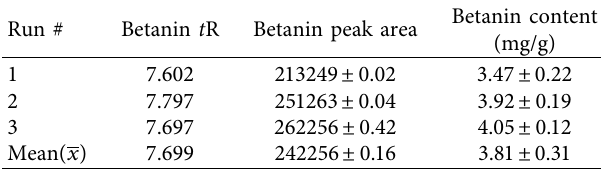
Results are shown as the mean values of three replicates ± SD and are expressed in mg/g. Table 5: Estimated percentage of betalains in the plant extract. Peak # Percent contribution in TBC